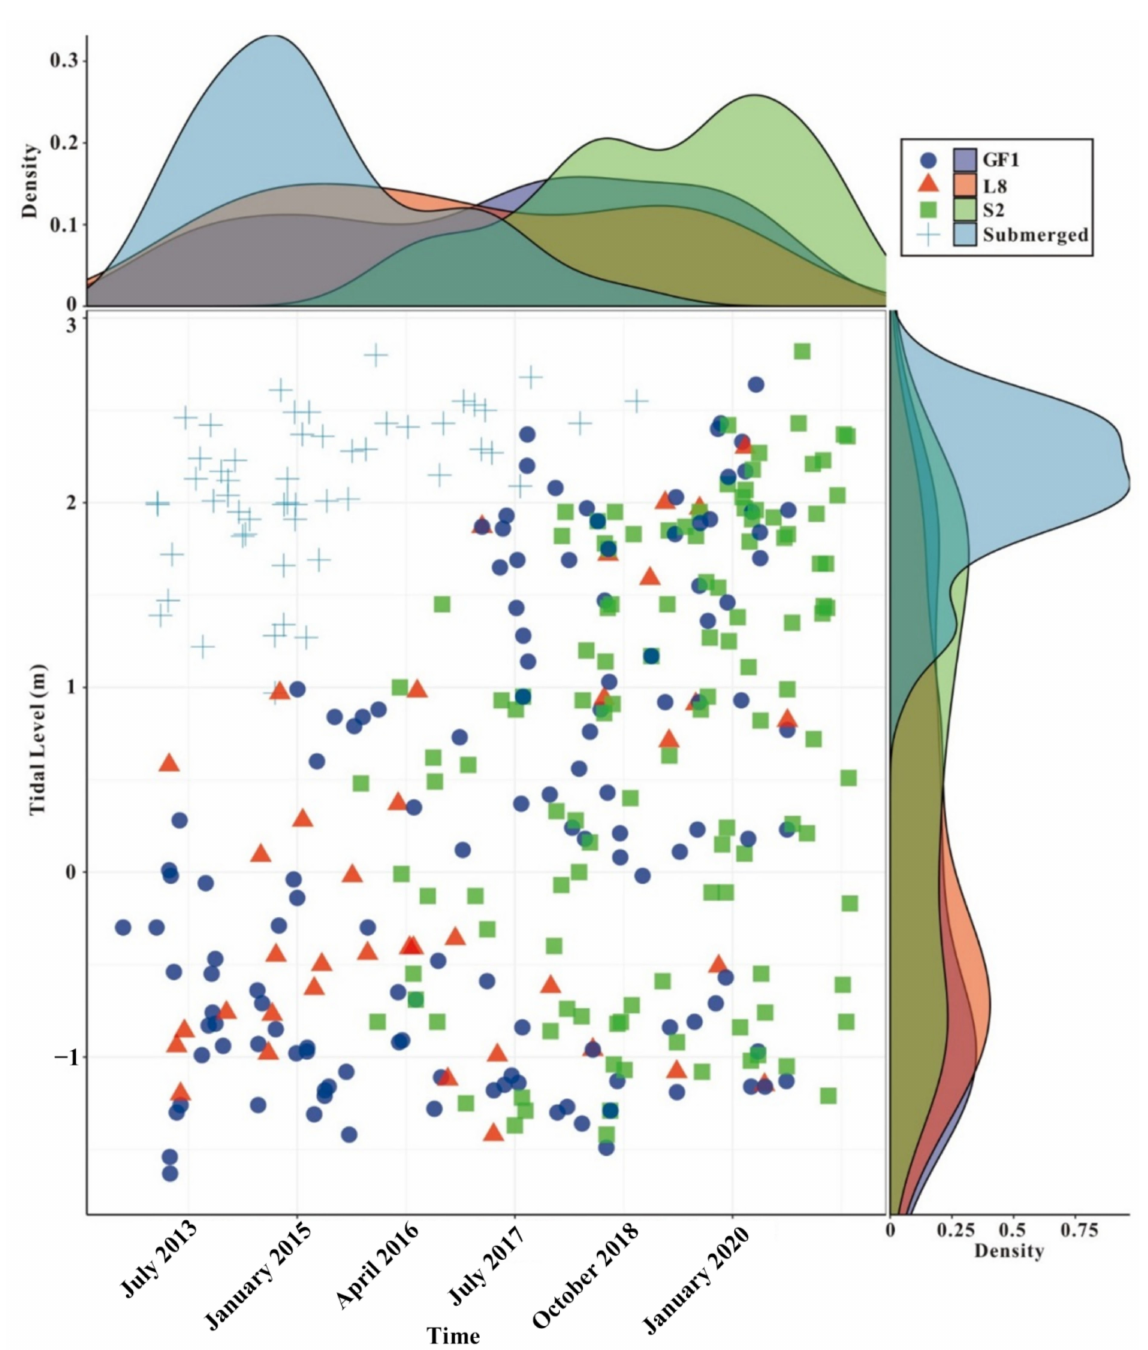
Figure 4. The satellite image time series and the corresponding tidal levels, the top and right panels show the trends of the relative data density. GF1: Gaofen-1; L8: Landsat-8; S2: Sentinel-2; and Submerged: The entire tidal flat is